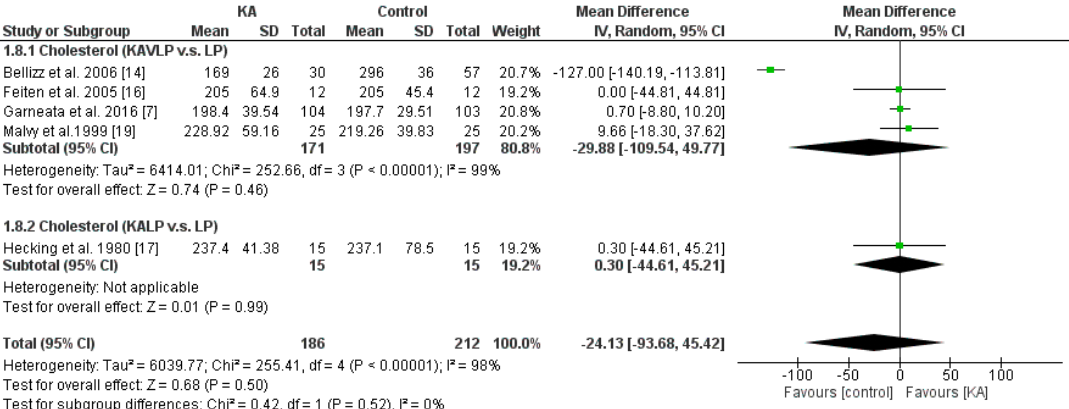
Figure 10. Forest plot of effects of KA on phosphorous in CKD patients sub-grouped by eGFR. The random-effects model was utilized. 3.4.2. Effects of KA on Serum Calcium To investigate the effects of KA on serum calcium, five RCTs and one non-RCT were included in the meta-analysis. Overall, the effect of KA on preventing calcium imbalance was not significant (MD = 0.07, 95% CI = ( − 0.02, 0.15), p = 0.11). However, subgroup analysis of patients with eGFR < 18 mL/min/1.73 m 2 showed significantly higher calcium levels in the KA group (MD = 0.08, 95% CI = (0.00, 0.16), p = 0.04). No significance was observed in the subgroup of eGFR > 18 mL/min/1.73 m 2